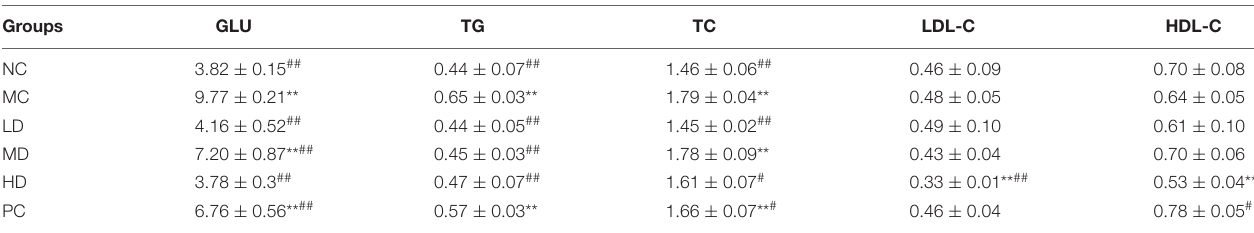
TABLE 1 | BRS improved glucose and lipid metabolism in obese rats (mmol /L). Groups